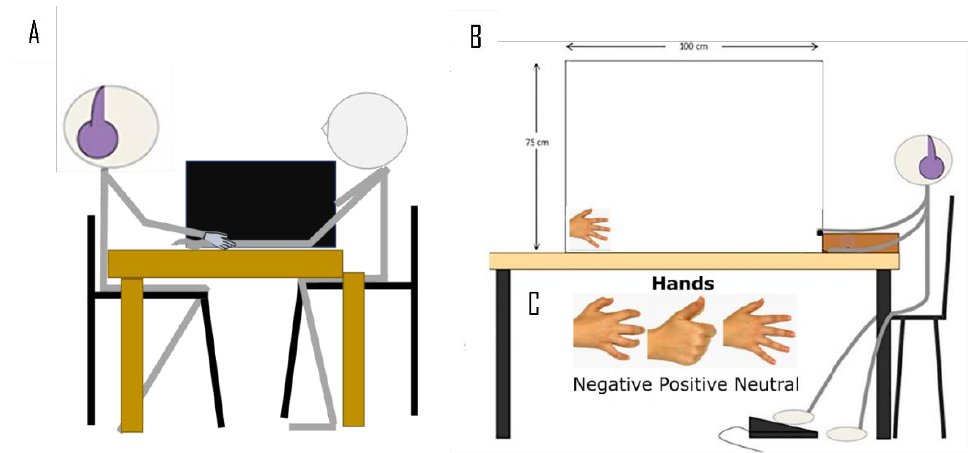
Figure 1. Sketch of the two experimental paradigms. ( A ) Rubber Hand Illusion paradigm administered in Experiment 1. The participant receives touches from the experimenter on both the rubber hand and the real hand with a slow (affective 3 cm/s) or fast (neutral 18 cm/s) stroking, either synchronous or asynchronous depending on the specific experimental condition. The participant is instructed to look at the rubber hand during the stimulation whose proximal edge was covered by a cloak; ( B ) Visuo-Tactile Interaction task administered in Experiment 2. The participant is seated in front of a table and looks at a looming visual stimulus while keeping attention on tactile stimulus that could be delivered when the visual one is located at 15, 30, 45, 60, 75, 90 cm from participant’s hand. The task is to respond as fast as possible to the tactile stimulus by pressing the foot pedal. The participant wears headphones, and a solenoid is attached to the right middle finger; ( C ) the three visual stimuli used in Experiment 2.